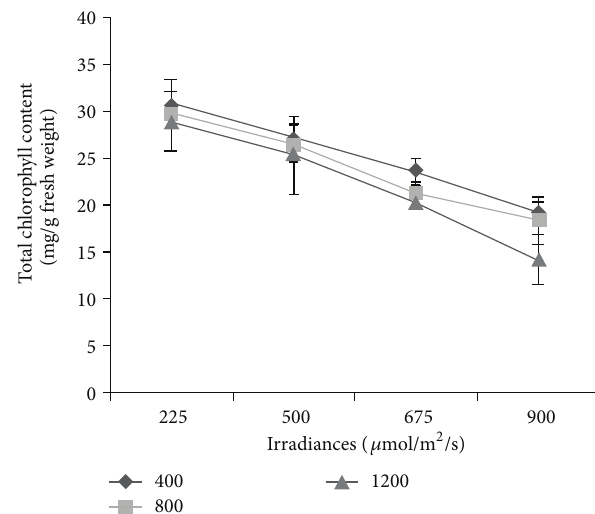
Figure 2: Interaction effects of CO 2 and irradiance on total chlorophyll content of Labisia pumila ; 𝑁 = 21 . Bars represent standard error of differences between means